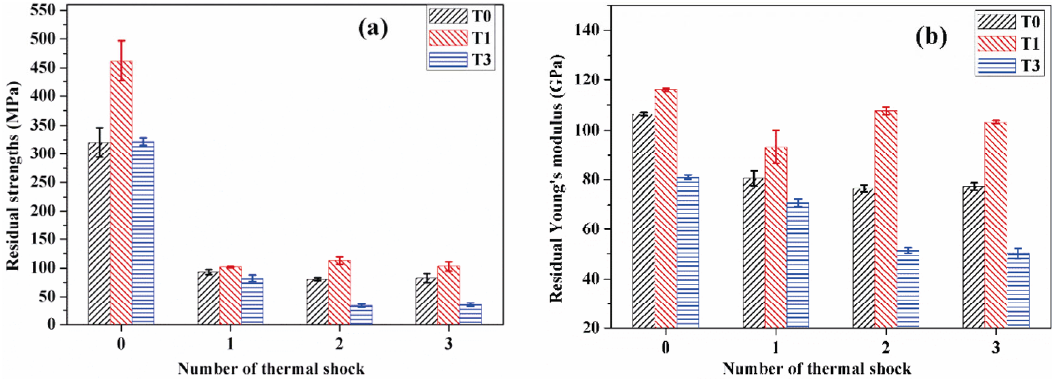
Fig. 6 (a) Residual strength and (b) Young’s modulus as a function of the number of thermal shock cycles at Δ T = 1000 ℃